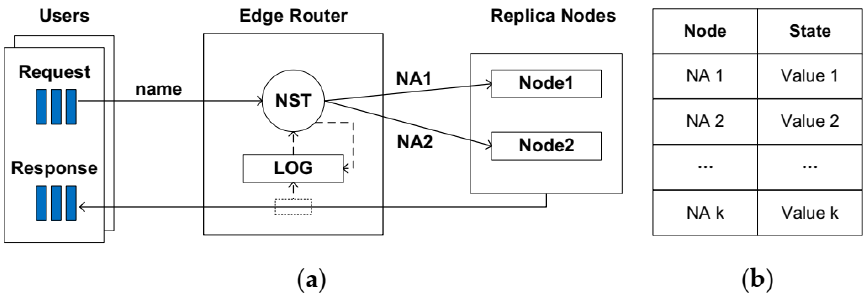
Figure 4. The mechanism of replica selection based on node state table (NST) includes ( a ) the working schema of NST and ( b ) the data structure of